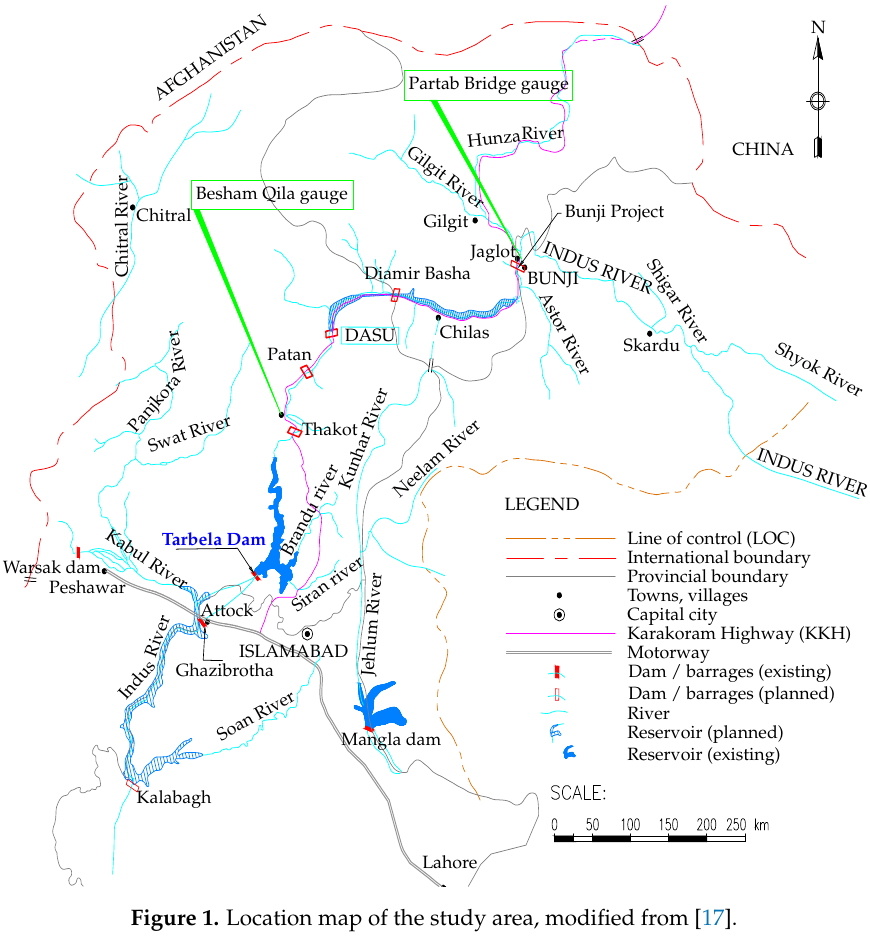
Figure 1. Location map of the study area, modified from [17].